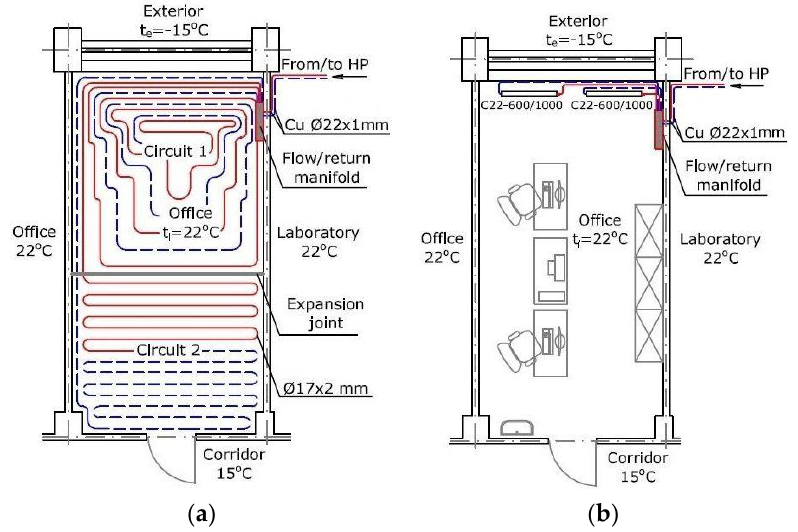
Figure 6. Schematic of heating systems: ( a ) Floor heating; ( b ) Radiator heating.